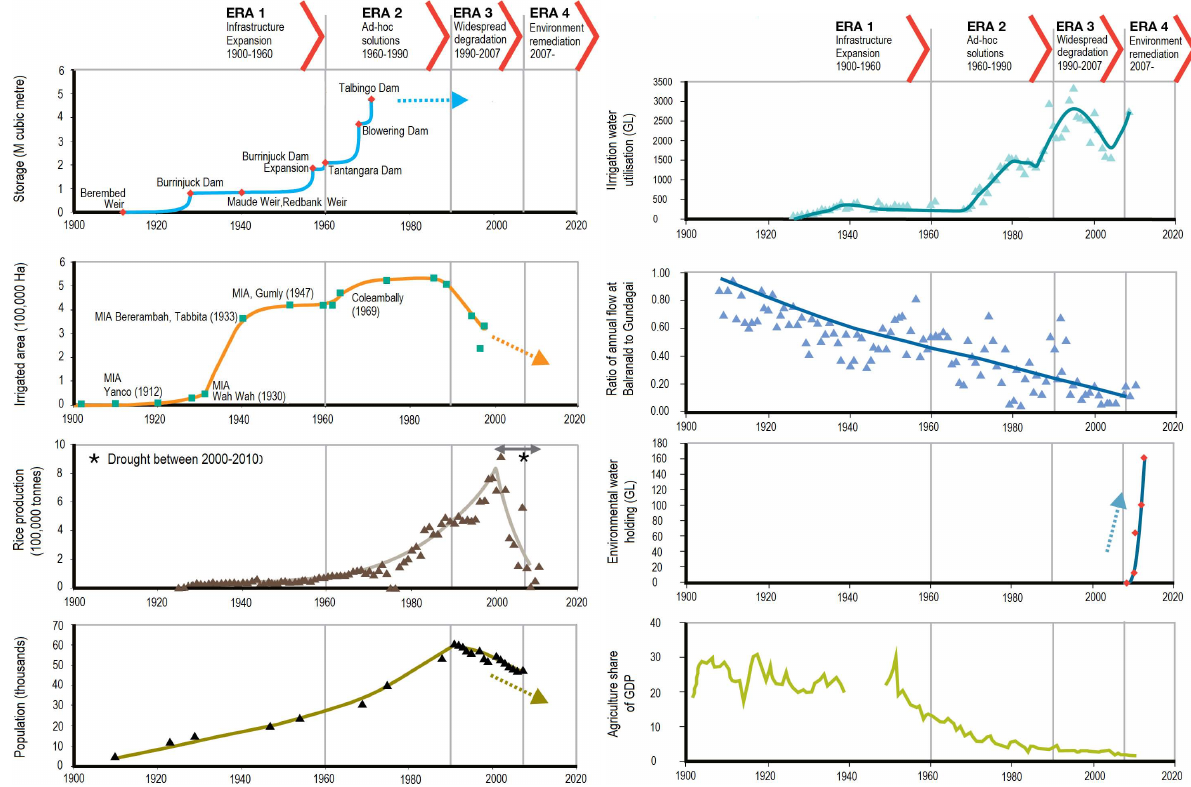
Fig. 4. (a) Development of storage in the Murrumbidgee Catchment (data sourced from NSW State Water Corporation). (b) Development of irrigation areas in the Murrumbidgee Catchment. See Fig. 1 for locations of irrigation area. Mirrool and Yanco are in the Murrumbidgee Irrigation Area. Bererembah, Tabbita, Wah Wah and Gumly are districts that adjoin Murrumbidgee Irrigation Area but not shown in Fig. 1, Lowbidgee irrigation area not included. (data sourced from ABS, 2013b). (c) Rice production in the Murrumbidgee, (data sourced from ABS, 2013b). (d) Population growth in the Murrumbidgee. Between 1900 and 1980 the population was estimated from data available in ABS year book. From 1980 onward the estimate is for the population of Murrumbidgee less the population of Canberra and Wagga Wagga, (data sourced from ABS 2013a, b). (e) Irrigation flow utilization in the Murrumbidgee Catchment, (data sourced from DWR, 1989; ABS 2013a; and State Water Corporation). (f) Ratio of annual flow in the Murrumbidgee at Balranald to the annual flow at Wagga Wagga, see Fig. 1 for locations of Balranald and Wagga, (data sourced from NSW State Water Corporation). (g) Environmental water holdings (water licenses) purchased by the Commonwealth Government and available to water sites of significant environmental value (wetlands, etc) in the Murrumbidgee Catchment, (data sourced from DSEWPC, 2013). (h) The contribution of agriculture to the Australian economy expressed as a percent of GDP (ABS,